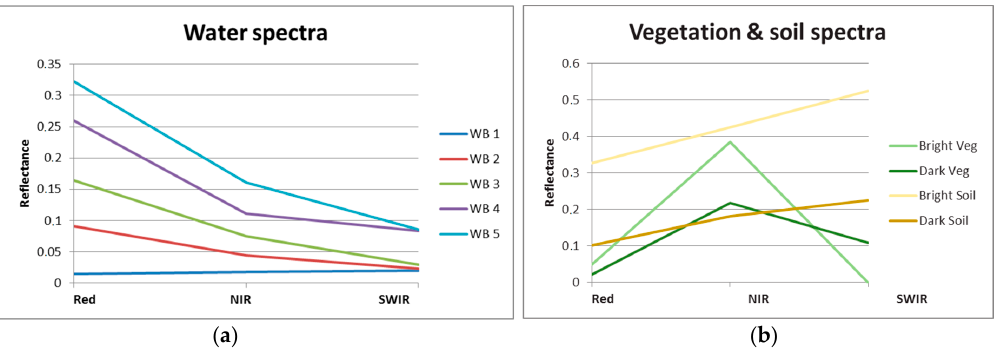
Figure 8. Spectra used in the spectral mixture analysis to define the minimum WB size in relation to the PROBA-V pixel size: ( a ) five water spectra with an increasing intensity; and ( b ) two vegetation and two soil spectra having a low and high reflectance.